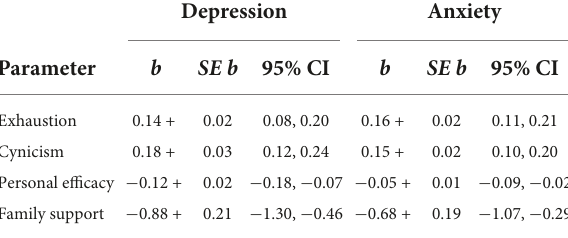
TABLE 4 Linear mixed model analysis of depression and anxiety as predictive factors ( N = 104).